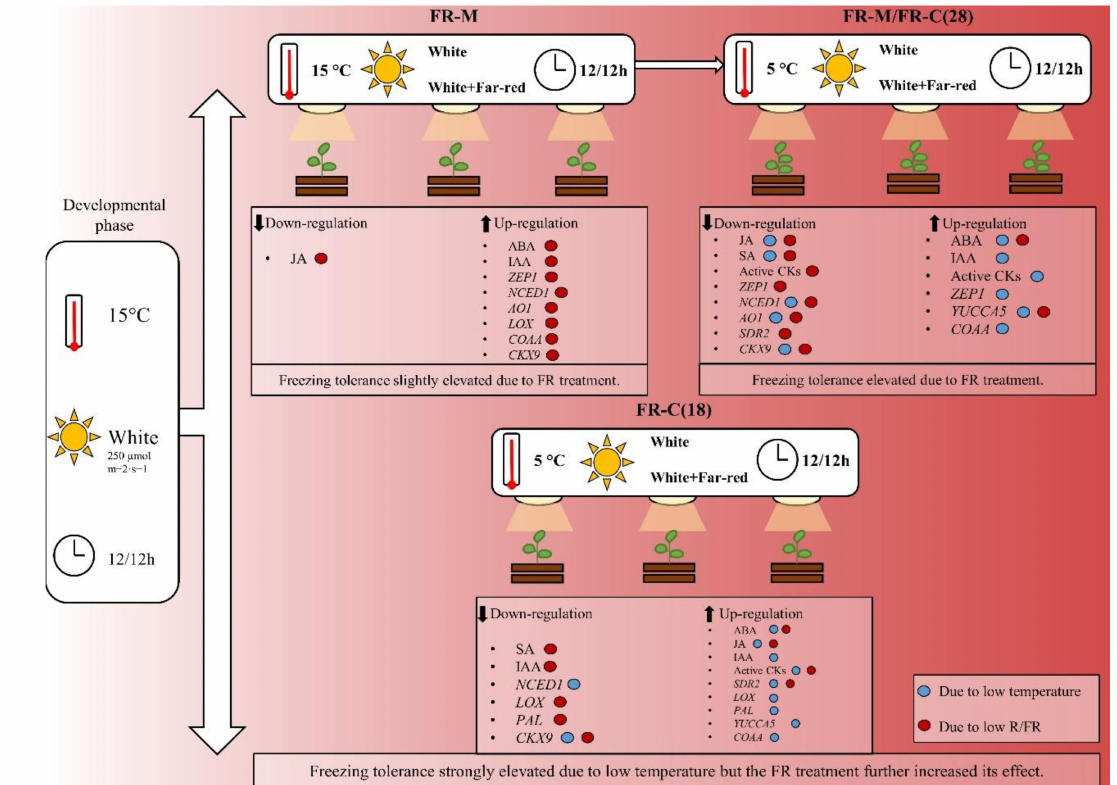
Figure 6. Summary of phytohormone responses and changes in the expression profiles of the key hormone metabolism- related genes elicited by low temperature treatment and/or FR enrichment. FR-M (Treatment 1): The plantlets were exposed to high FR at the age of 18–28 days under constant 15 ◦ C. FR-M/FR-C(28) (Treatment 2): The plantlets were subjected to high FR for 10 days at 15 ◦ C, then the temperature was dropped to 5 ◦ C for seven days (at high FR). FR-C(18) (Treatment 3): The plantlets were 18 days old when the temperature was dropped to 5 ◦ C for seven days (at high FR). ABA: abscisic acid; IAA: indole-3-acetic acid; JA: jasmonic acid; SA: salicylic acid; cZ: cis -zeatin; active CKs: active cytokinins; CKX9: cytokinin oxidase/dehydrogenase 9; COAA: acetyl-CoA acetyltransferase; YUCCA5: indole-3-pyruvate monooxygenase; ZEP1: zeaxanthin epoxidase; NCED1: 9-cis-epoxycarotenoid dioxygenase1; SDR2: short-chain dehydrogenase; AO2: aldehyde oxidase 2; LOX: lipoxygenase; PAL: phenylalanine